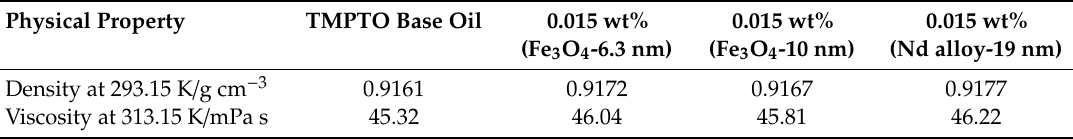
Table 2. Main physical properties of trimethylolpropane trioleate (TMPTO) base oil and the three